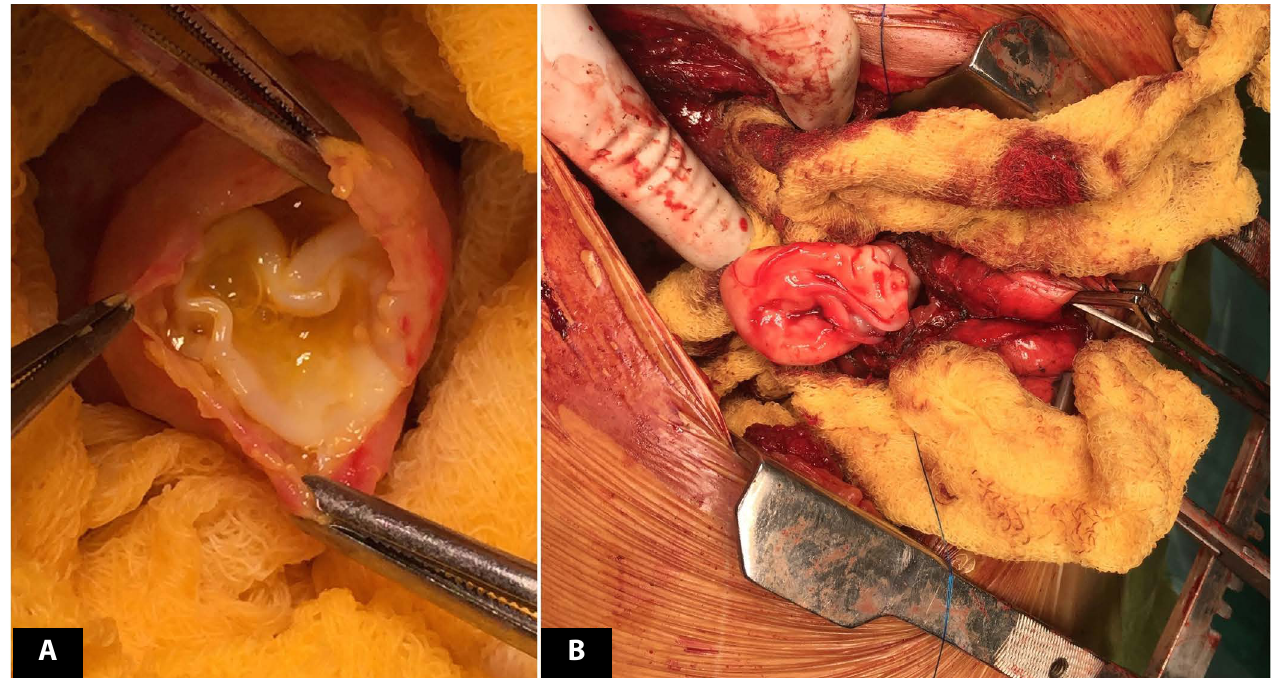
Fig. 2 - Intraoperative photograph of intramyocardial left ventricular hydatid cyst (A) and pulmonary hydatid cyst